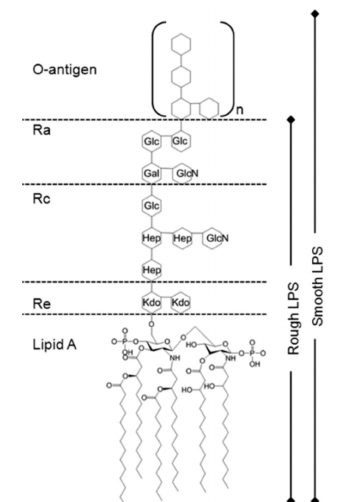
Figure 5. Schematic of the organization of Escherichia coli lipopolysaccharide (LPS). LPS was from the rough mutant J5 strain of E. coli O111:B4, which produces a Rc chemotype with a core oligosaccharide as describedbyMüller-Loenniesetal. TheoriginalRmutants, whichdefinedthedi ff erentchemotypeswere from Salmonella minnesota , so in this paper we use the terms Ra / Rc to denote the chemotype of E. coli LPS used according to this convention. Kdo, 2-keto-3-deoxyoctonic acid; Hep, l-glycero- d -manno heptose; Glc, glucose; Gal, galactose; GlcN, glucosamine. The Lipid A tails consists of four (R)-3-hydroxy-mystic acids, one myristic acid, and one lauric acid. Additional phosphates and ethanolamines on Kdo and Hep have been omitted for clarity. (Reproduced with permission from [95], copyright 2013 American Chemical Society).